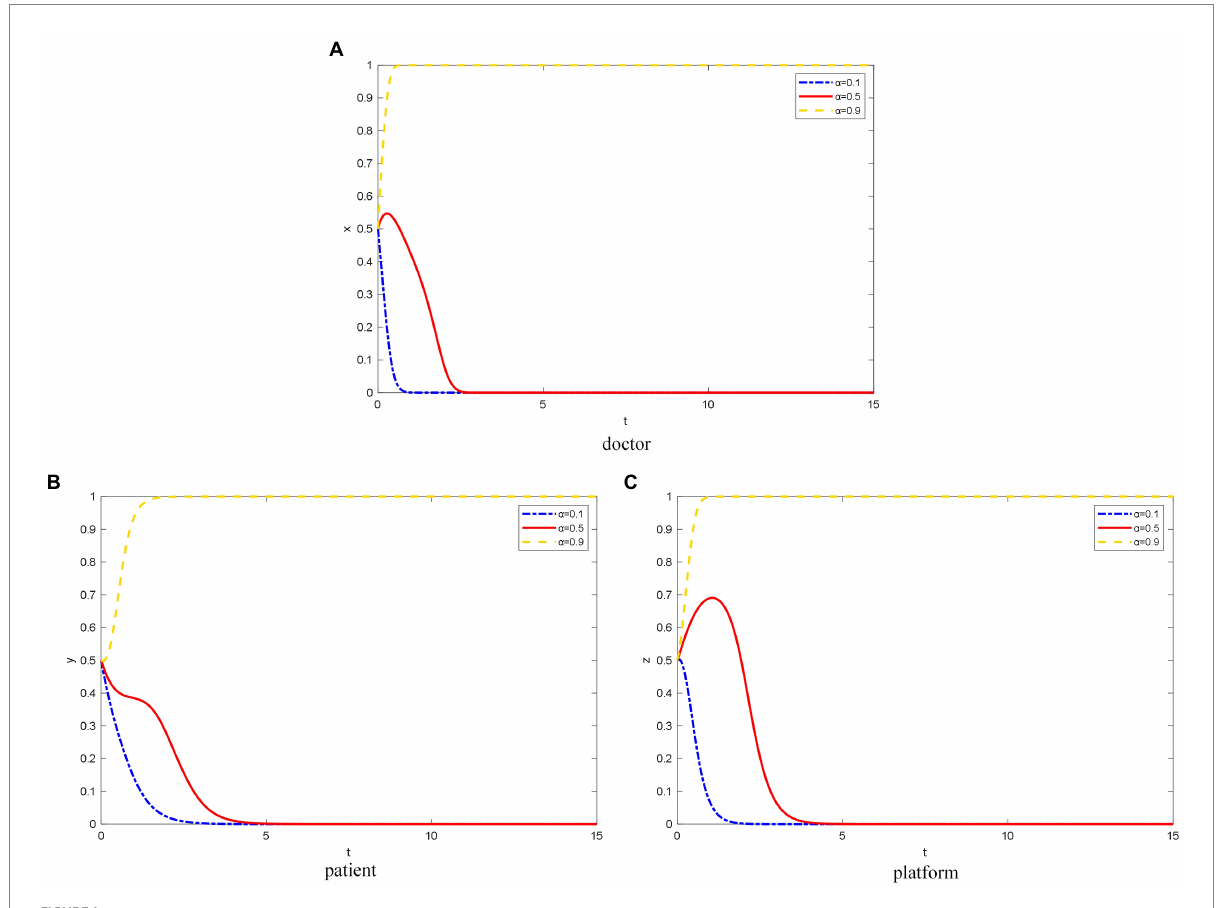
FIGURE 1 The evolution path of different objects’ strategy under different QISC. (A) Doctor, (B) patient, (C)